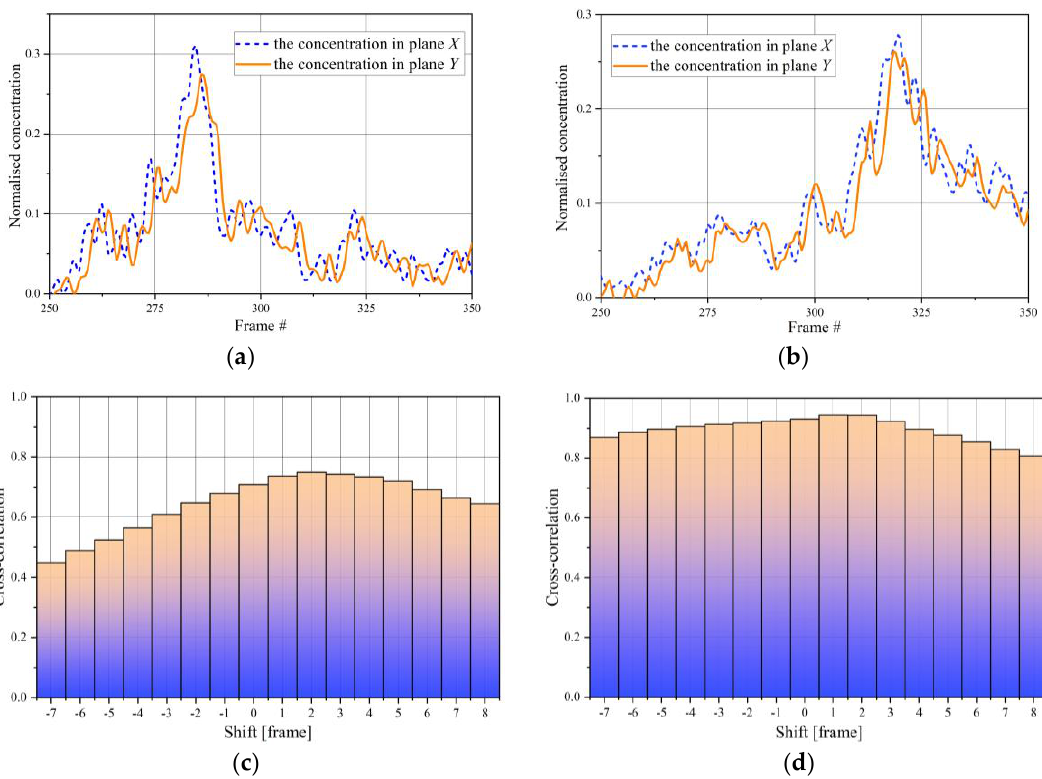
Figure 7. ( a ) Normalized concentration of the chosen pixel (15,15), ( b ) appropriative cross correlation functions at specified time intervals [#270, #305] and [#303, #345] by the proposed algorithm; ( c , d ) appropriate cross- correlation functions.